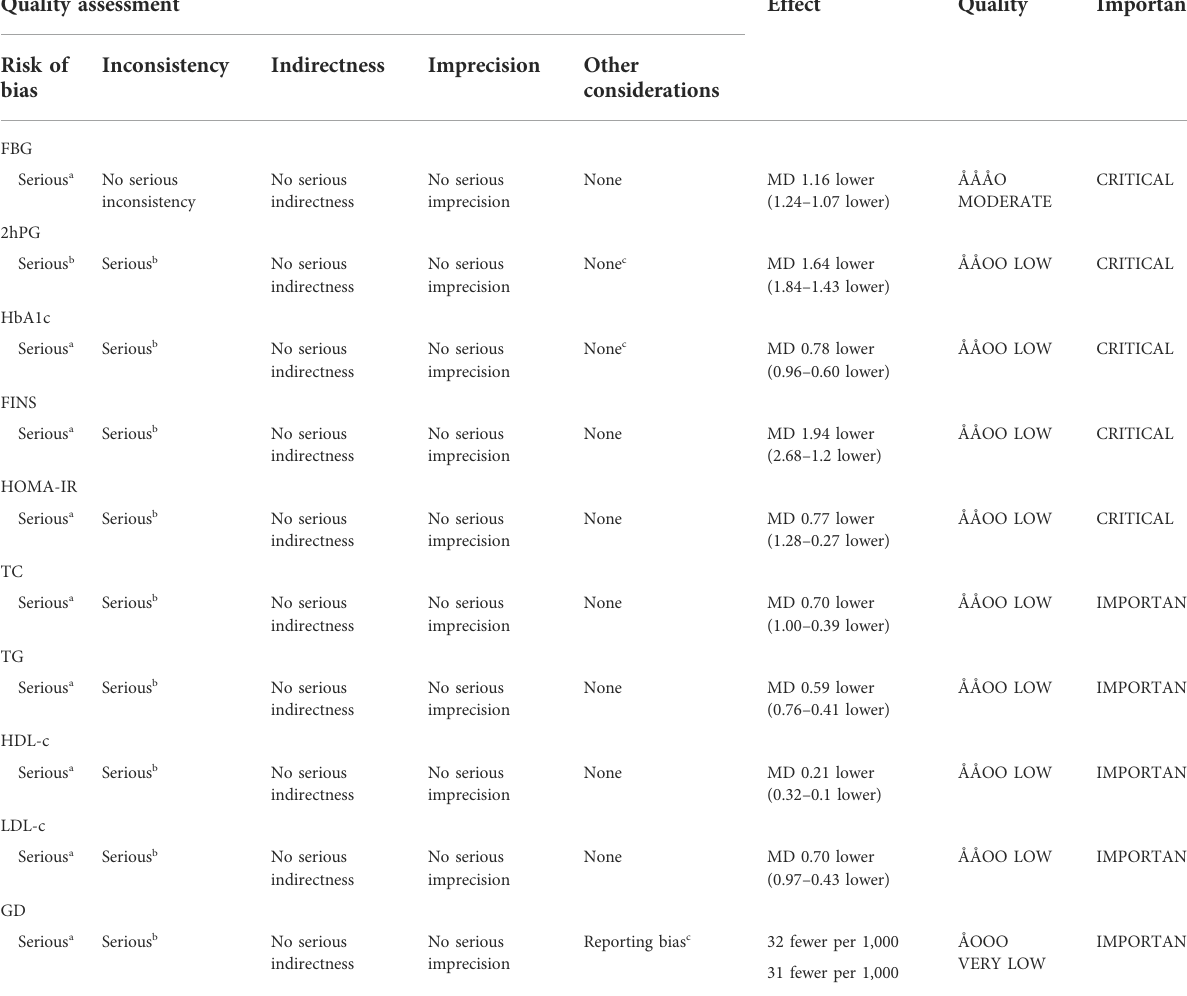
TABLE 3 GRADE evidence pro fi le of clinical ef fi